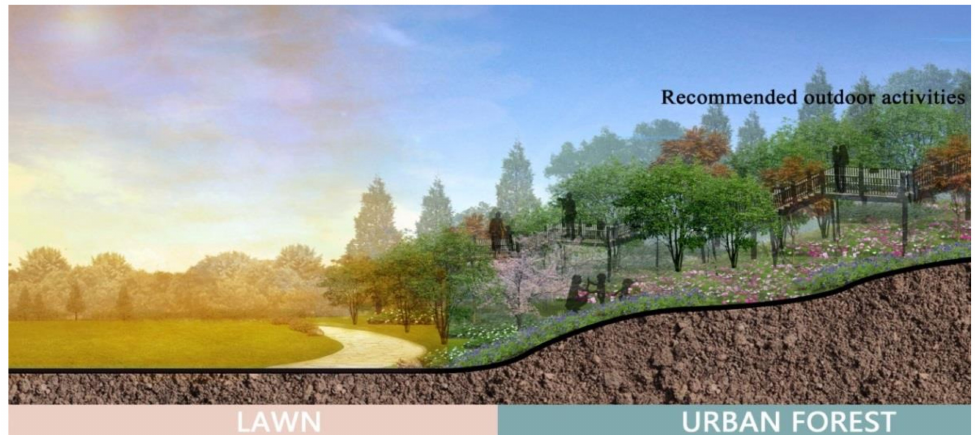
Figure 10. Schematic diagram of the influence of vegetation structure on airborne particulate mat- ter